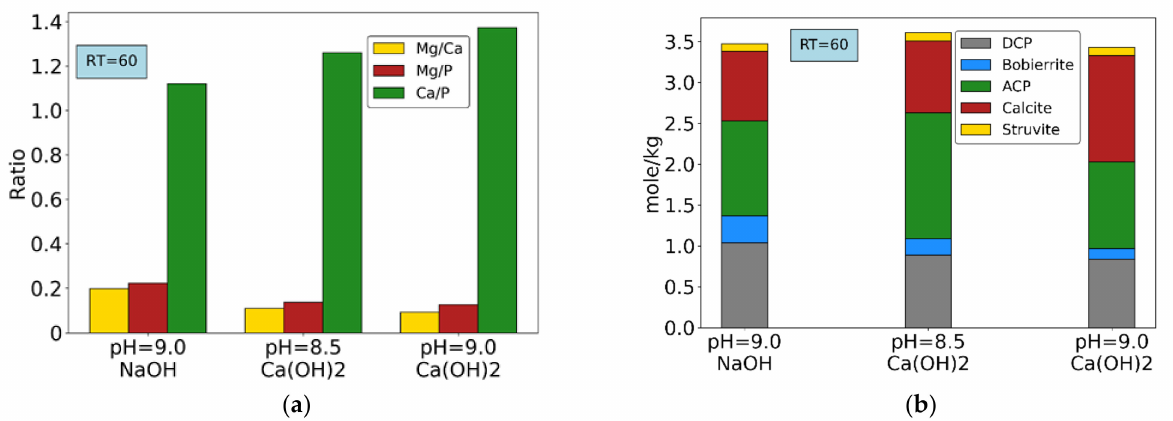
Figure 9. Experiments without chemical addition (only pH buffer reagents): ( a ) Molar ratios of main components. ( b ) final precipitates